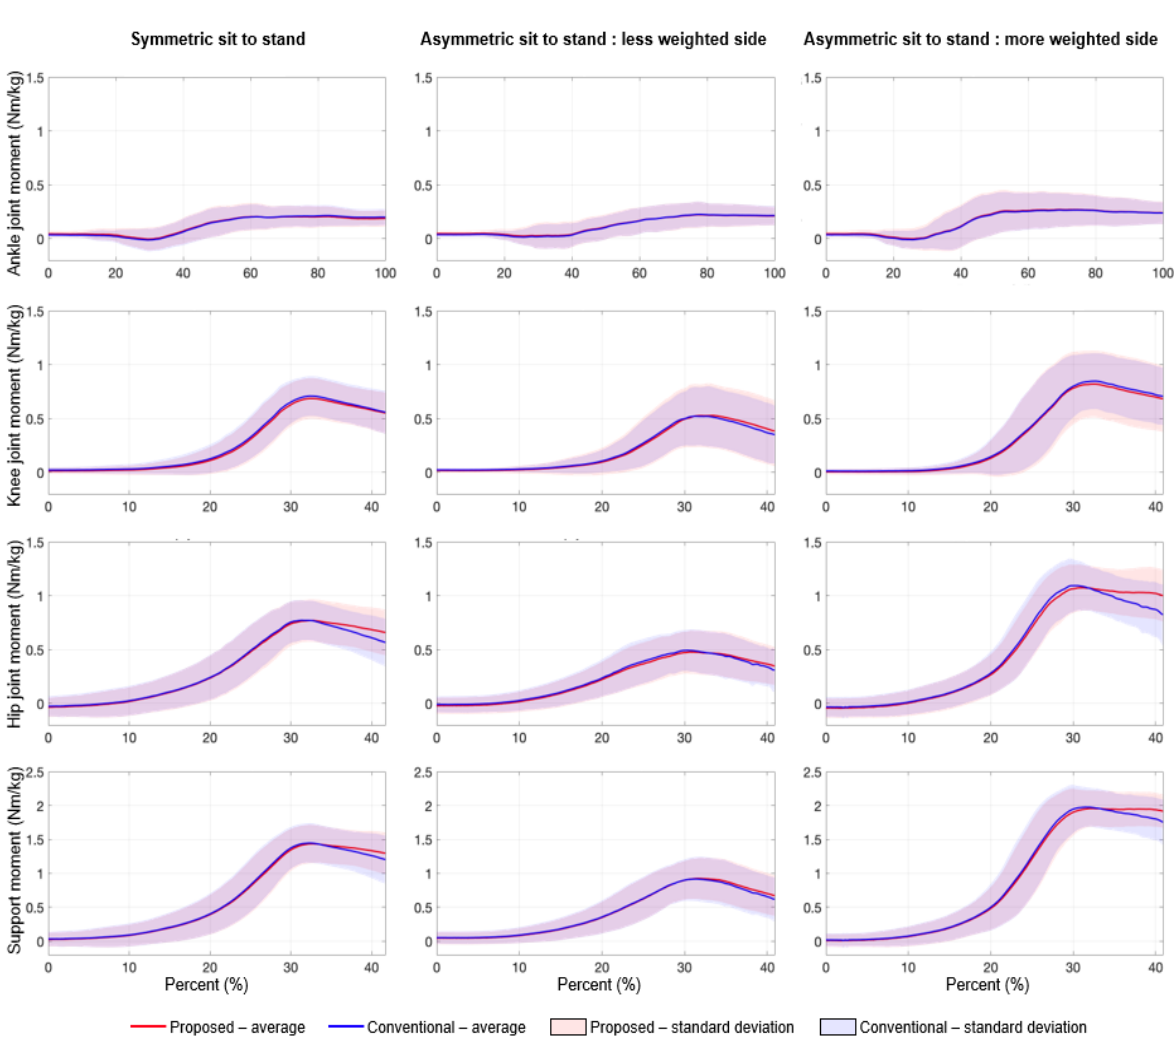
Figure 3. Comparison of joint moments and support moment estimated by the proposed system and measured by the conventional (Mocap-based) system. Note that knee and hip joint moments and support moment were obtained within the effective estimation range.